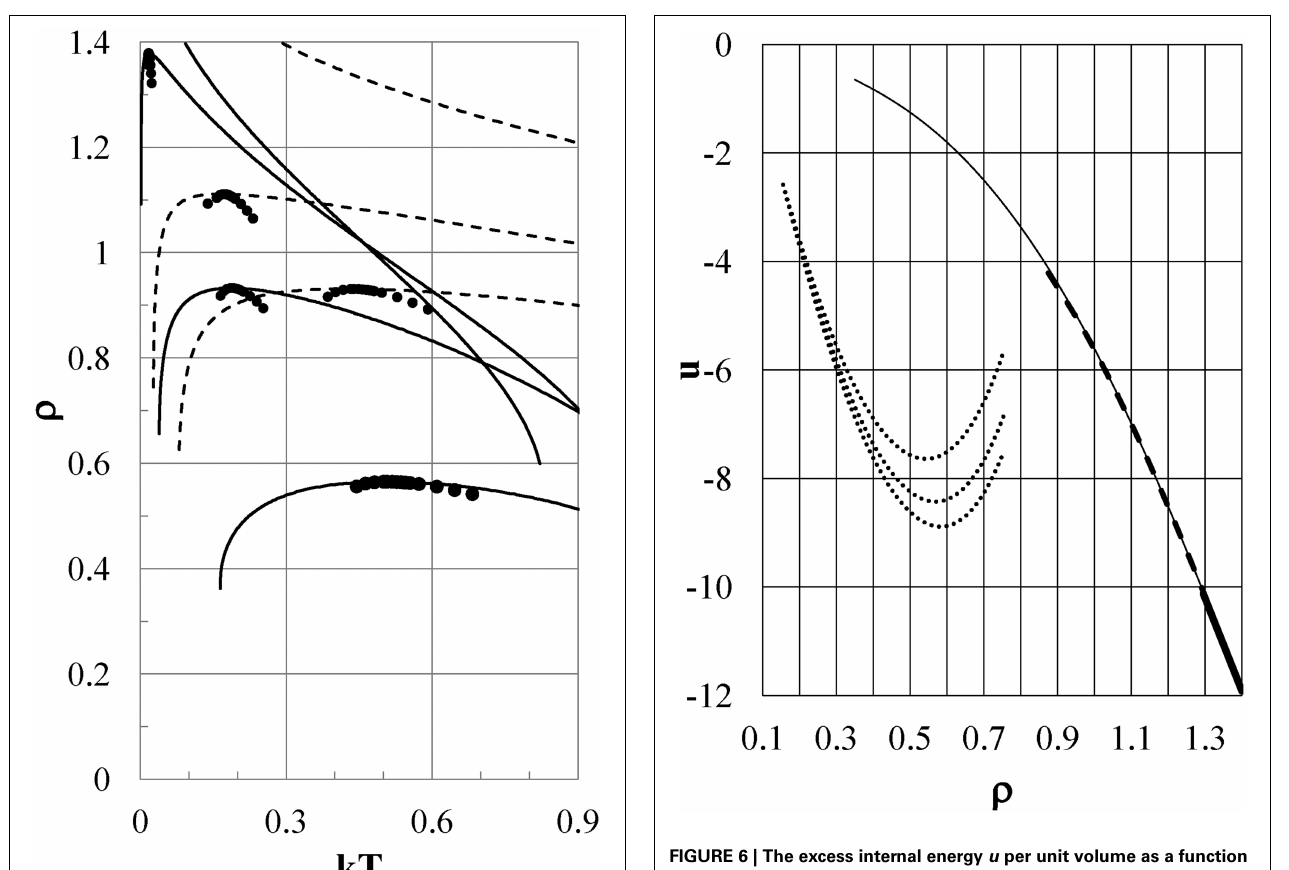
FIGURE 6 | The excess internal energy u per unit volume as a function of density ρ . Dotted lines: u - ρ curves at T ( ◦ C) = + 20, + 4, and − 20 from the bottom to the top of the figure, respectively, for Model φ 6 . Thin full, dashed, and thick full lines are for kT c = 0 . 896, kT = 0 . 372, and kT = 0 . 0324, respectively, for Model φ 5